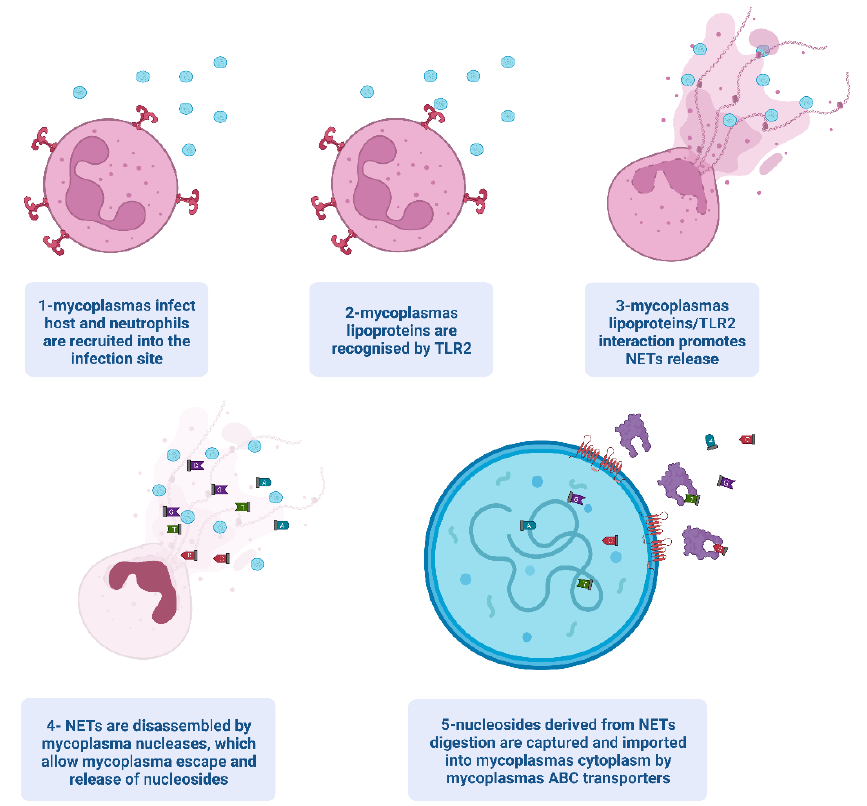
Figure 1. Mechanism of NET induction and disassembling and the mycoplasma uptake of generated nucleotides. Created with BioRender.com.